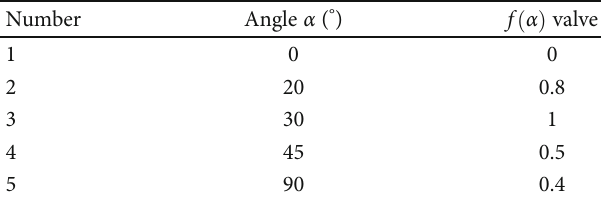
Table 1: The relationship between f ð α Þ and α